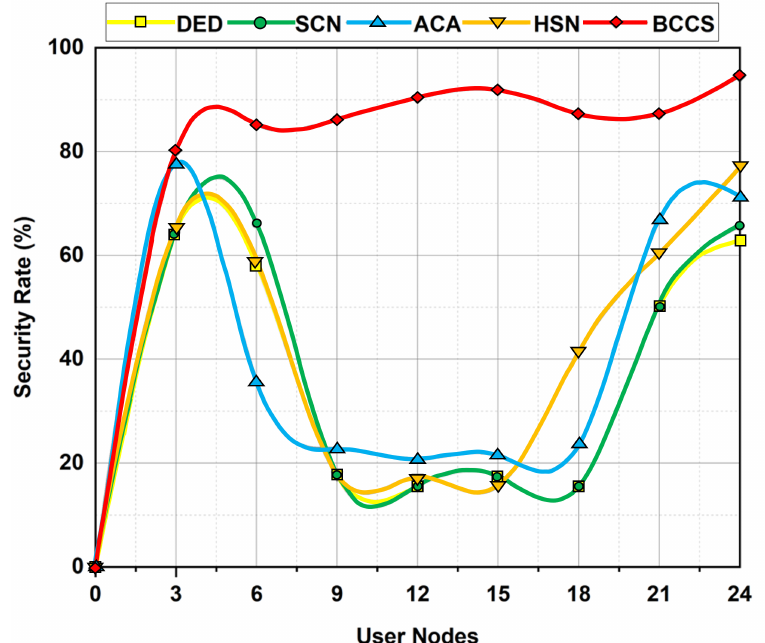
Figure 8. Security rate (user